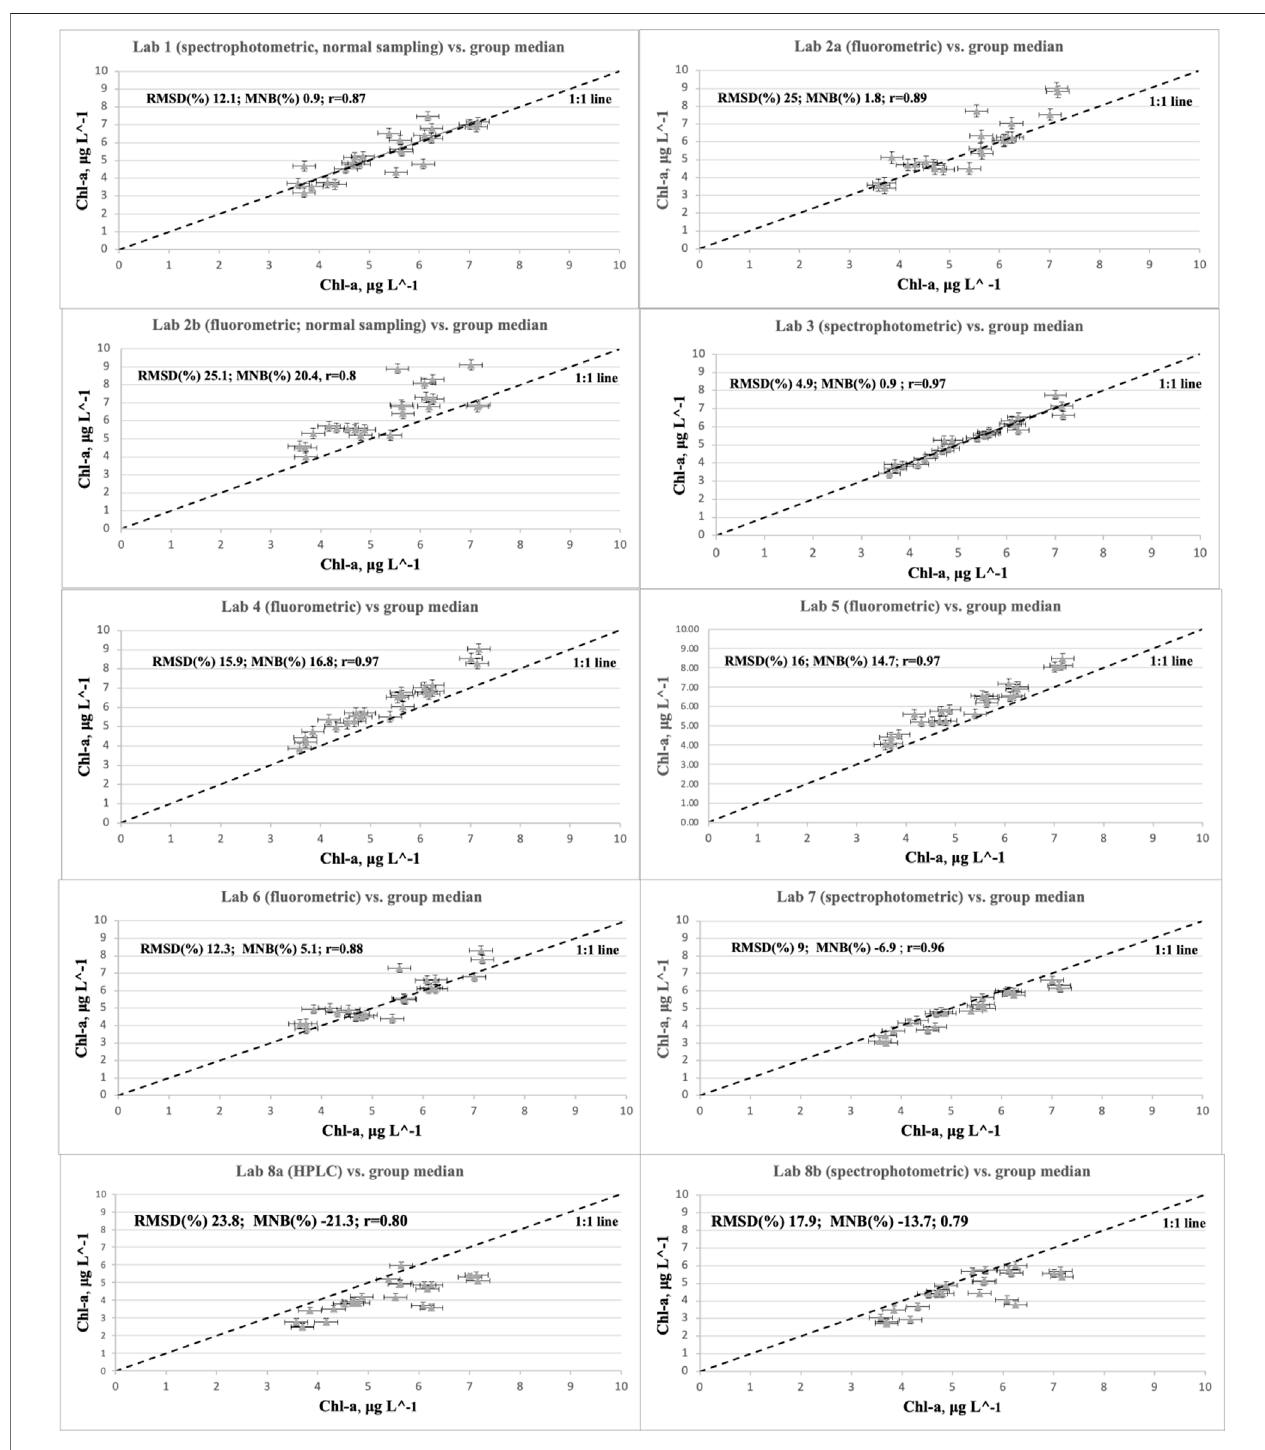
FIGURE 3 | Result of the correlation analysis per laboratory. The 1:1 line was plotted here to allow for a visual comparison between laboratories. The results from each laboratory( y -axis) were plotted against the median value ofall spectrophotometric and fl uorometric laboratories( x -axis). The HPLC measurements lie, on average, 23% below the spectrophotometric and fl uorometric measurements. The statistics are summarized in Table 2 for a quick and easy comparison.